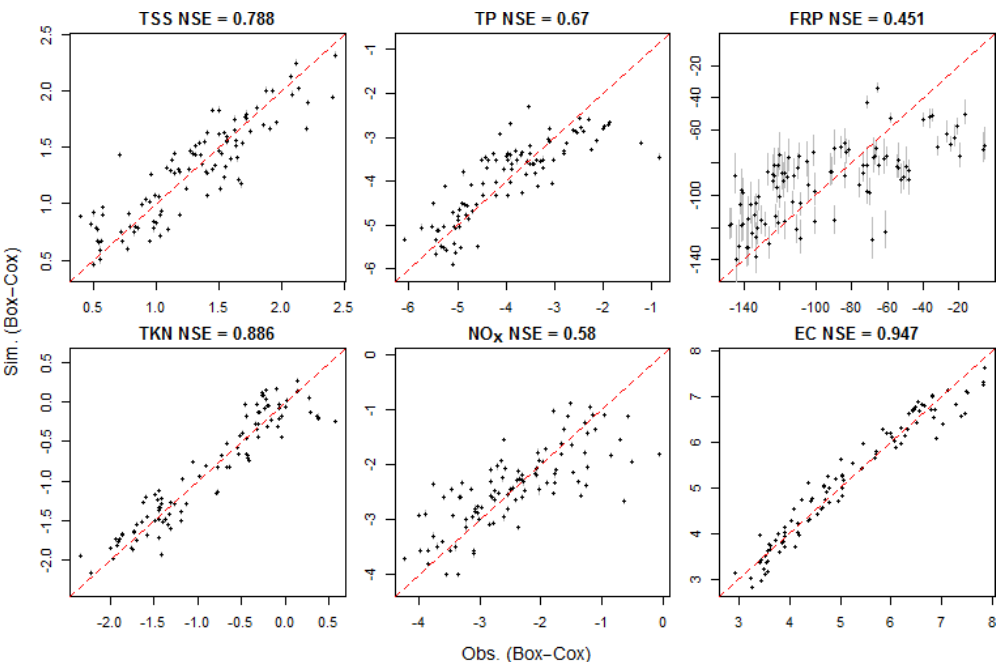
Figure 4. Model fit for the site-level mean concentration at the 102 calibration sites for six constituents, with the 95% upper and lower bounds of the posterior simulations shown using vertical gray lines. All simulations and observations are presented in Box–Cox-transformed space. The NSE for each constituent is also shown, and red dashed lines show the 1 : 1 lines.